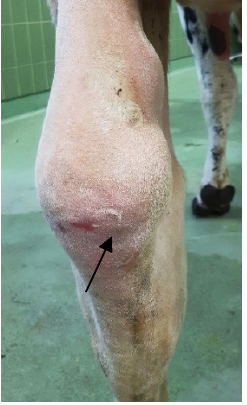
Figure 1. Caudomedial view of the left calcaneal region of a 6.5-year-old Holstein cow (115 days in lactation, non-pregnant) showing evident swelling over the calcaneal tuber (CT) region and proximally thereof, indicating severe effusion of the subcutaneous calcaneal bursa (SCB) caused by a wound on the plantar aspect (black arrow) of four-weeks duration.